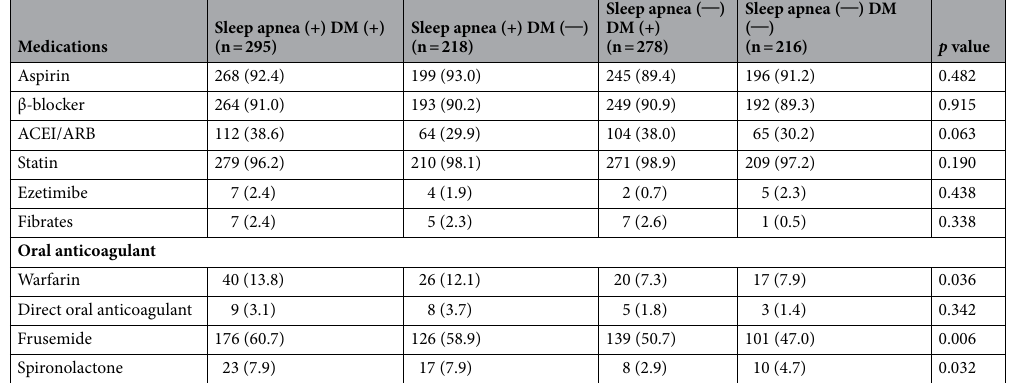
Table 4. Medications upon discharge. ACEI angiotensin converting enzyme inhibitor, ARB angiotensin receptor blocker, DM diabetes mellitus.